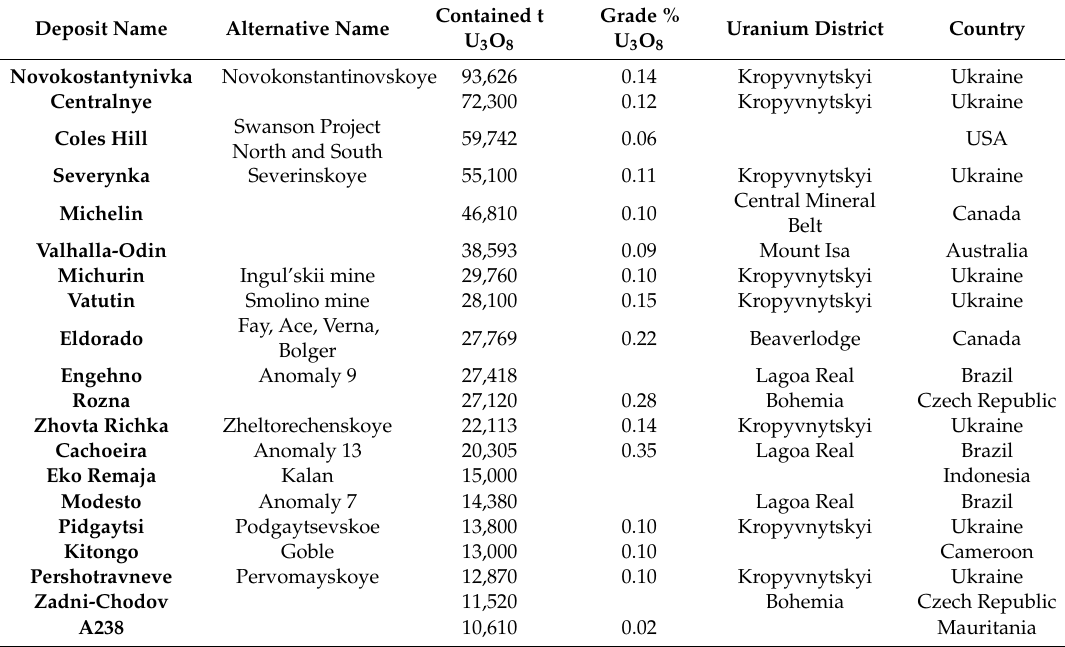
Table 2. Average grade and contained uranium of the top 20 shear-hosted uranium